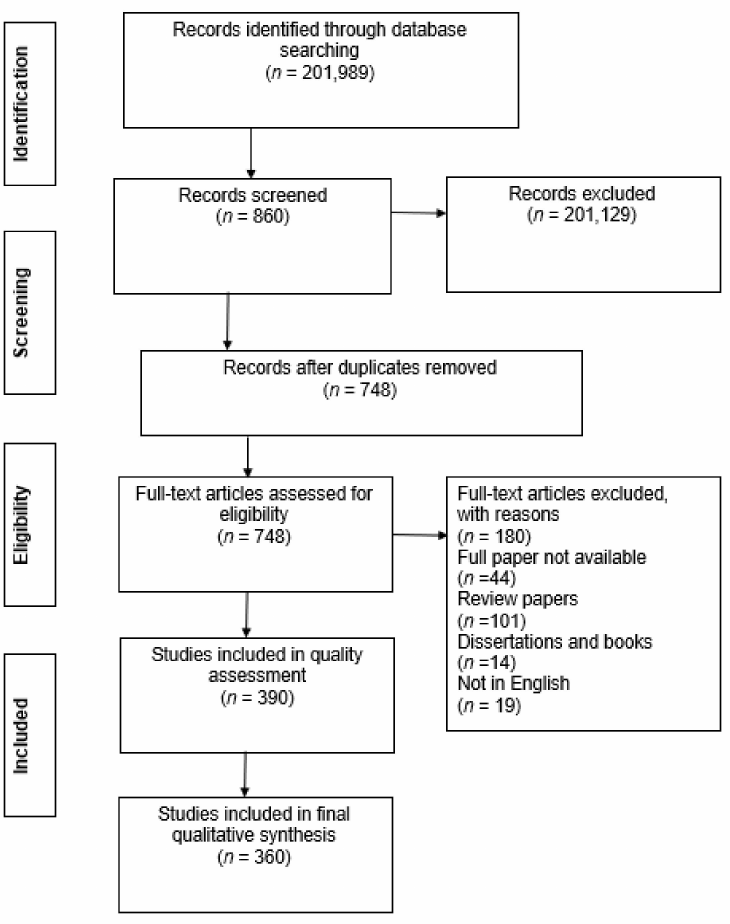
Figure 1. PRISMA protocol of search strategy and